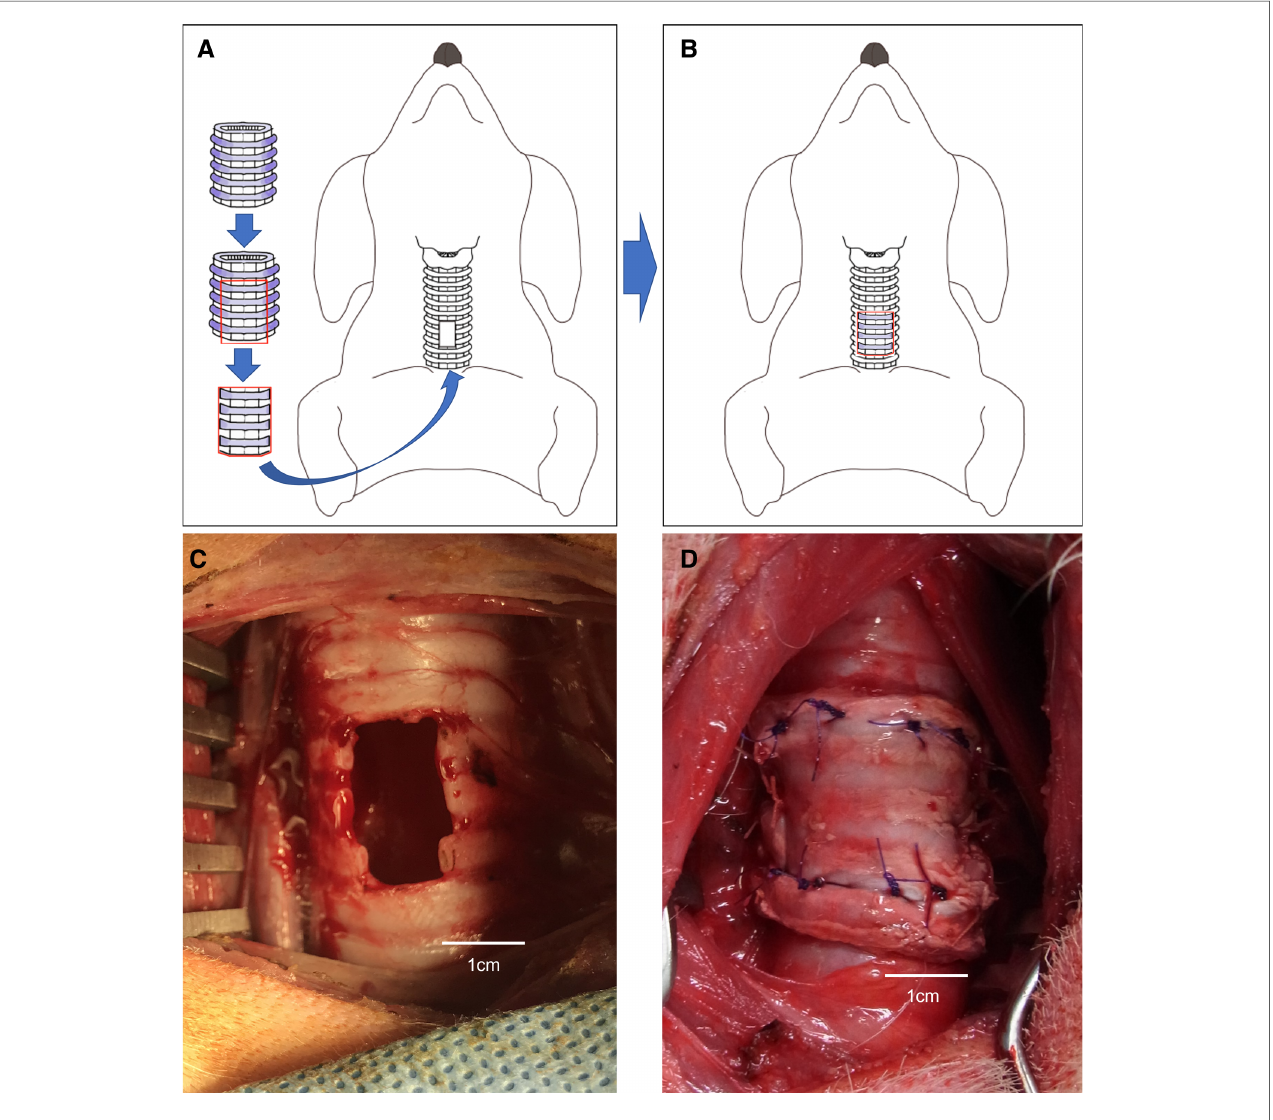
FIGURE 2 ( A,B ) Schema of the porcine extracellular matrix (P-ECM) transplanted parallel to a tracheal defect (hole) in a dog. ( C ) Tracheal defect (hole) in a dog. ( D ) Porcine extracellular matrix (P-ECM) transplanted parallel to the tracheal defect (hole) in a